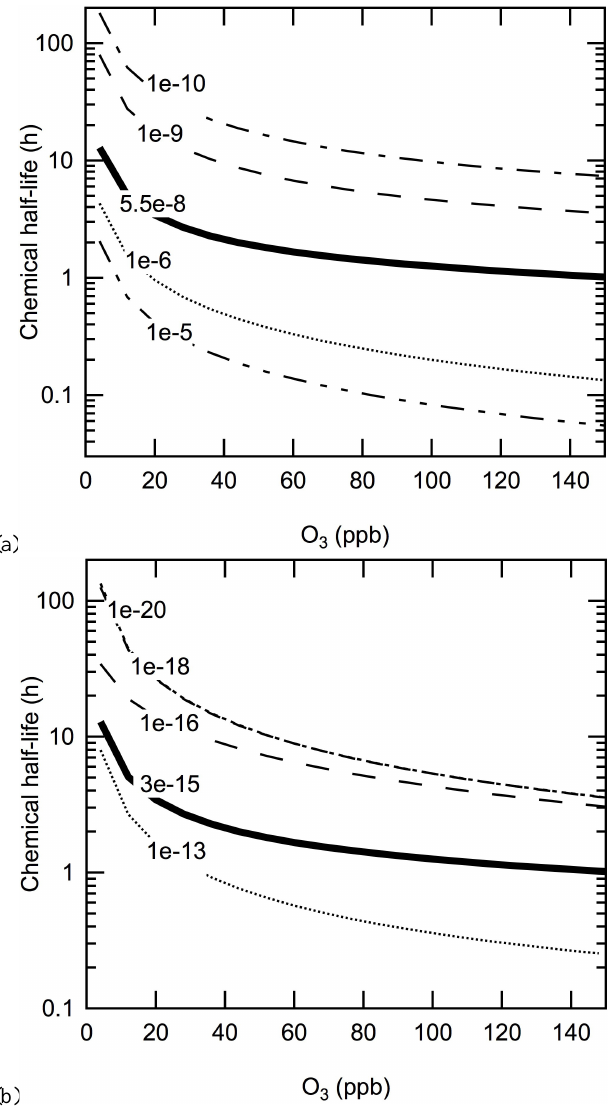
Fig. 8. Chemical half-life of oleic acid in the 12-component mixed aerosol matrix with a particle radius of 275nm as a func- tion of gas phase ozone mixing ratio. (a) With fixed D b , Y , 0 (3 × 10 − 15 cm 2 s − 1 ) and D b , O are varied between 10 − 10 – 3 , 0 10 − 5 cm 2 s − 1 . (b) With fixed D b , O (5 . 5 × 10 − 8 cm 2 s − 1 ) and 3 , 0 D b , Y , 0 are varied between 10 − 20 –10 − 13 cm 2 s − 1